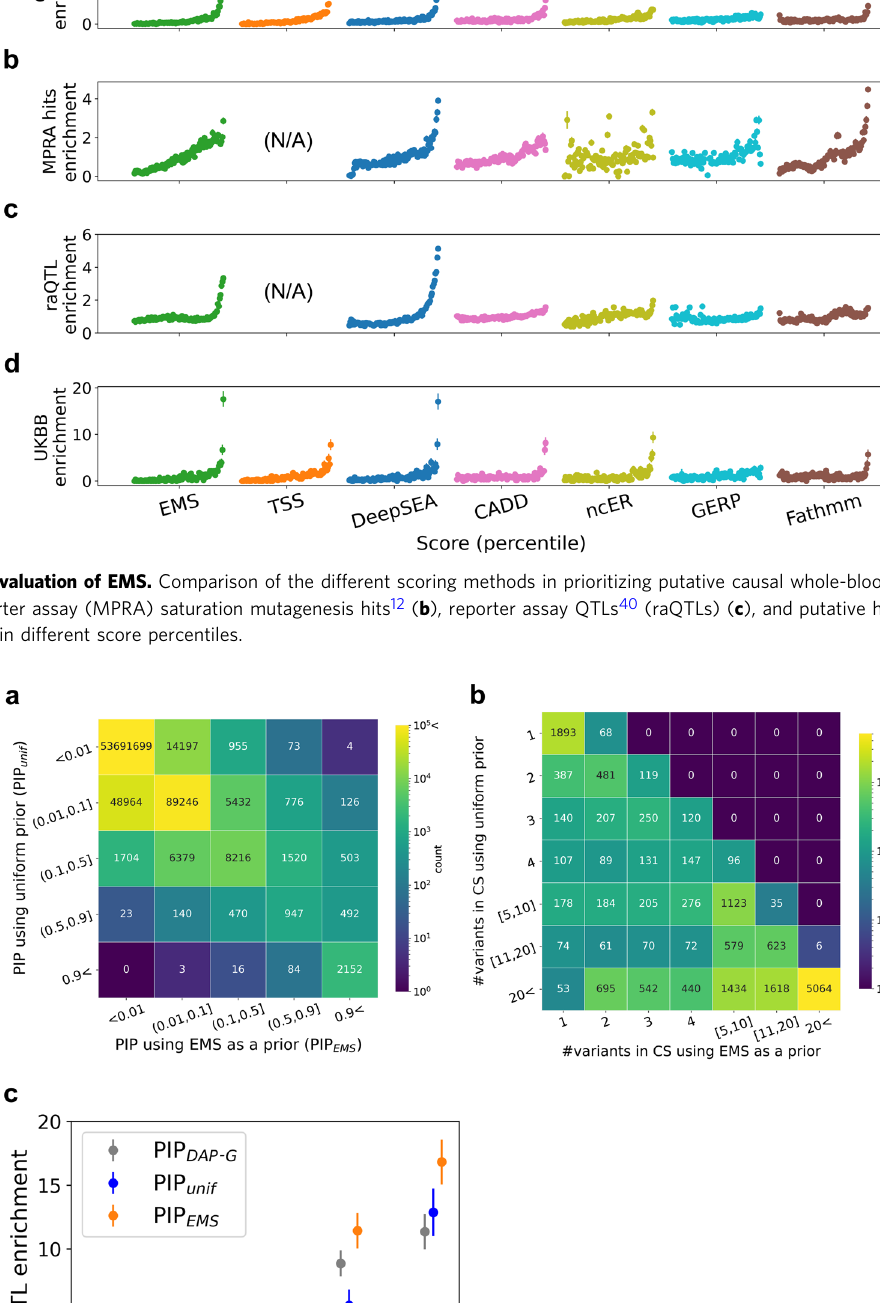
NATURE COMMUNICATIONS| (2021) 12:3394 |https://doi.org/10.1038/s41467-021-23134-8|www.nature.com/naturecommunications